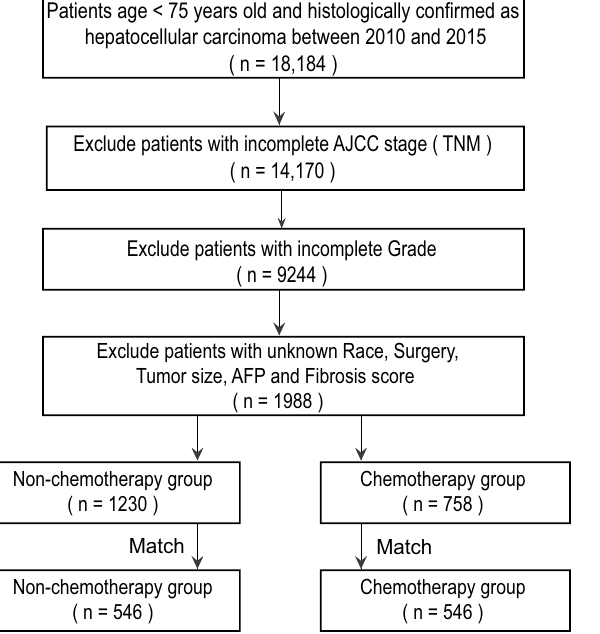
Figure 1. Flowchart of patients selection. AJCC, American Joint Committee on Cancer (7th). AFP, alpha-